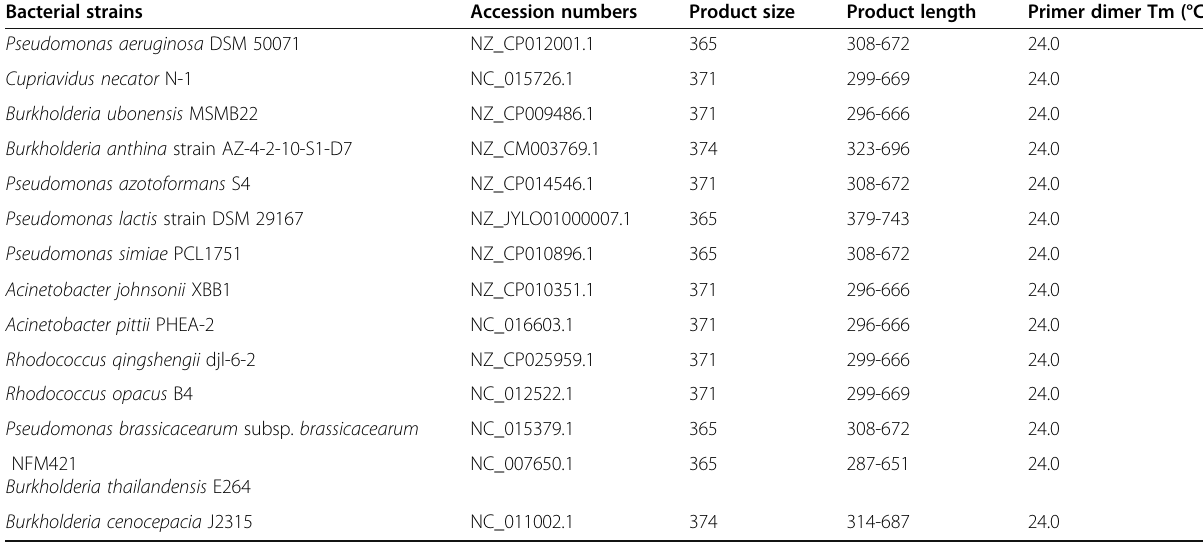
Table 9 In silico PCR analysis of primer pair catAf/catAr with targeted sequences Bacterial